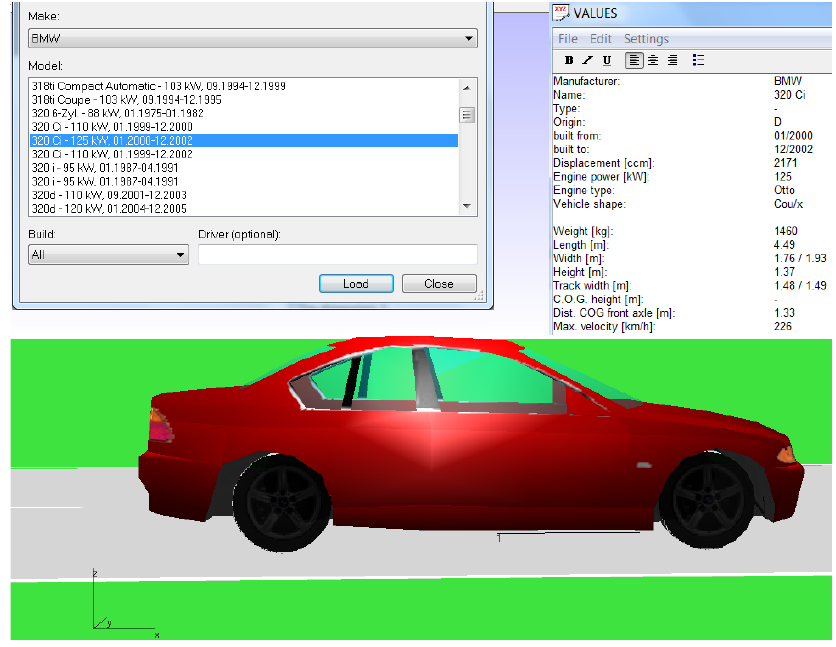
Figure 1. Program PC CRASH 8.1 car